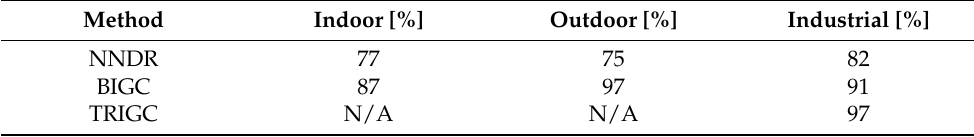
Table 1. Performance comparison between NNDR, BIGC, and TRIGC methods: real matching set. Method